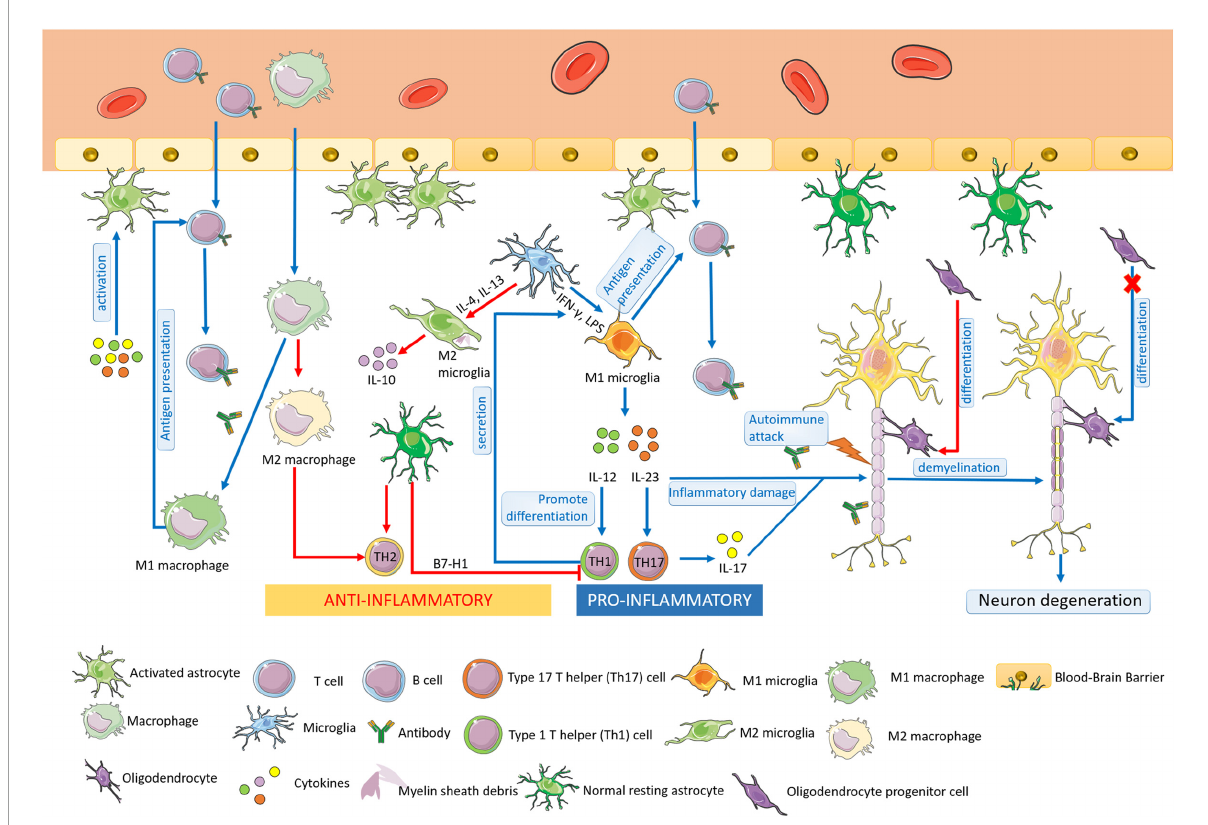
FIGURE1 The pathogenesis of MS. Multiple sclerosis (MS) is an autoimmune disease characterized by chronic inflammation, demyelination, and gliosis in the CNS. At the early stage of MS, microglia could be activated and proliferated, which act as antigen-presenting cells. M1 microglia are differentiated by IFN- γ and LPS, secreting IL-12 and IL-23, promoting the differentiation of Th1 cells and Th 17 cells, leading to the aggravation of the inflammatory response of MS. M2 microglia are activated by IL-4/IL-13 and play a role in anti-inflammation. Macrophages have similar functions as microglia, including the presentation of antigens and cytokines production. M1 macrophages have the antigen-presenting ability the same as M1 microglia, resulting in the demyelination of nerves in MS. M2 macrophages increases Th2 cell differentiation to protect oligodendrocytes and neurons from damage. In MS, astrocytes can be activated, enhancing the permeability of BBB, and recruiting lymphocytes into the CNS. Moreover, astrocytes participate in the formation of BBB and secret immune inhibitory factors, acting in an anti-inflammatory role. The resting astrocytes inhibit the proliferation and promote apoptosis of Th1 cells and promote the secretion of anti-inflammatory cytokines by Th2 cells. Oligodendrocytes form the myelin sheath of CNS axons, providing nutrition and protecting nerve axons. At the early stage of MS, the regeneration and self-healing of nerve myelin sheath lesions are completed by the differentiation of OPCs into mature oligodendrocytes, but the differentiation ability is finally lost in progressive